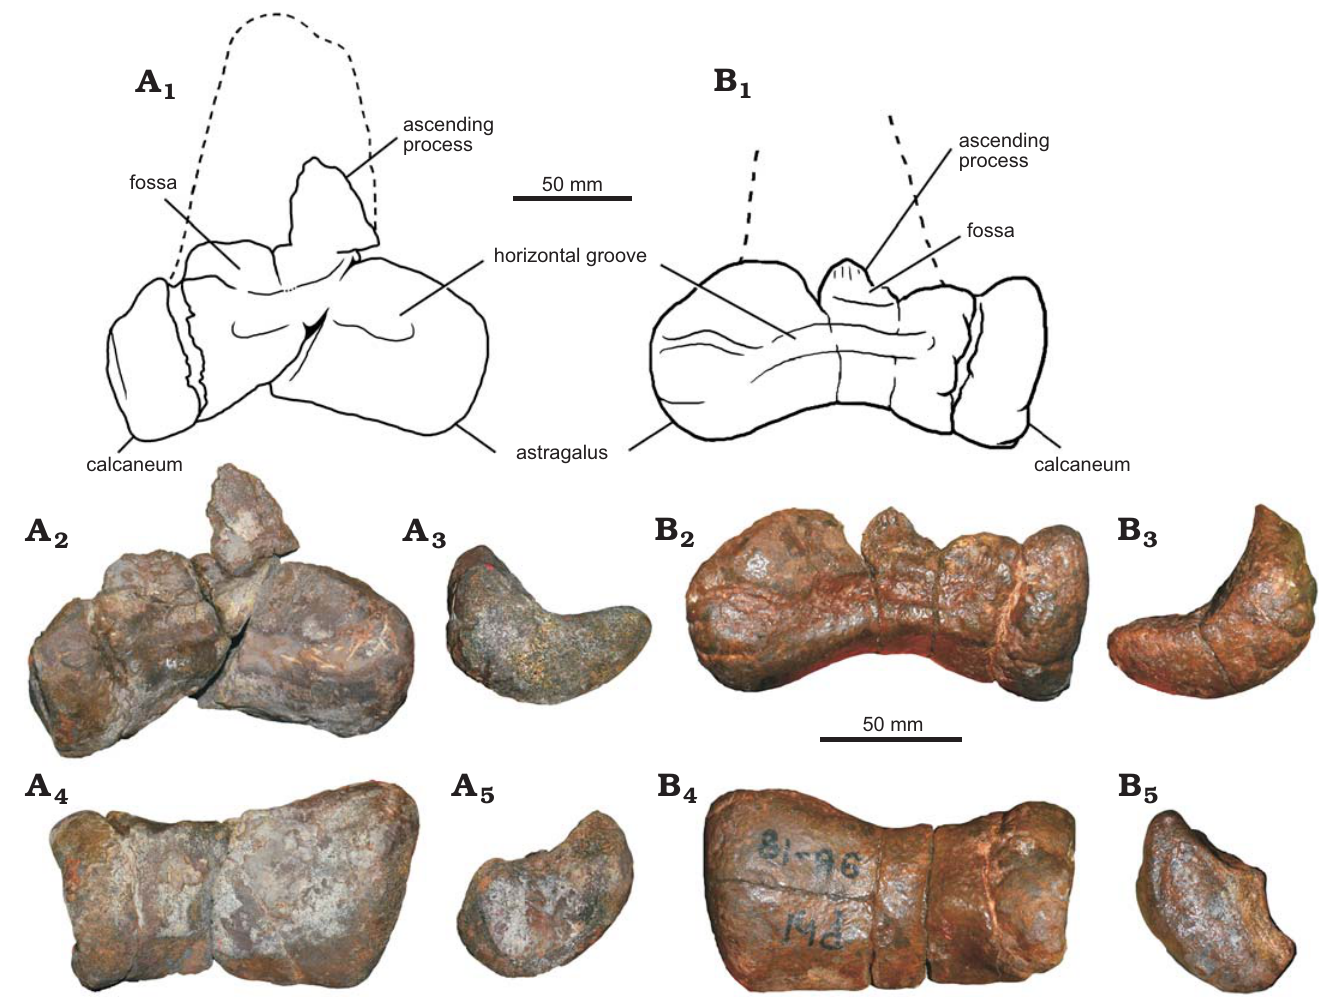
Fig. 10. Phuwiangvenator yaemniyomi gen. et sp. nov. from the Early Cretaceous Sao Khua Formation of Phu Wiang, Khon Kaen Province, Thailand. SM- PW9A-B17, right ( A ) and SM-PW9B-18, left ( B ); astragalocalcaneum in anterior (A 2 , B 2 ), medial (A 3 , B 3 ), distal (A 4 , B 4 ), and lateral (A 5 , B 5 ) views; line drawings in anterior view (A 1 , B 1 ). Dashed lines are the reconstruction of the ascending processes of the